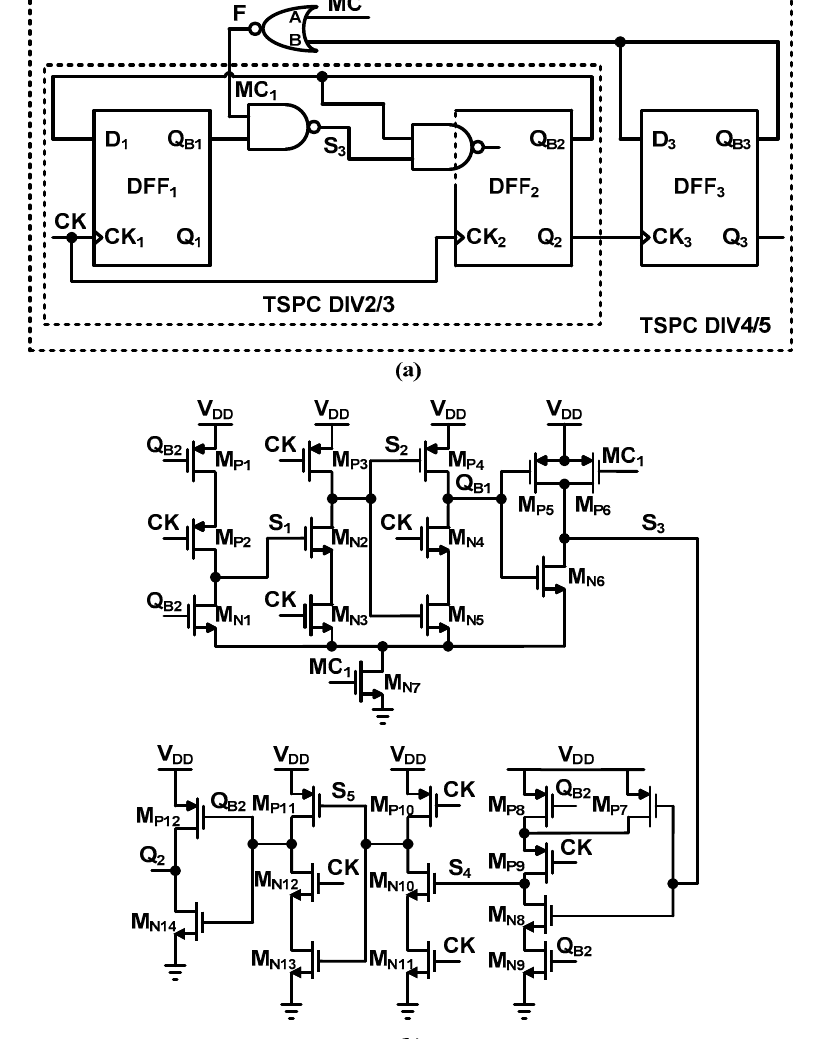
Figure 2. ( a ) Block diagram of the proposed divide-by-2 / 3 and divide-by-4 / 5 prescalers, ( b ) schematic of the proposed divide-by-2 / 3 prescaler.